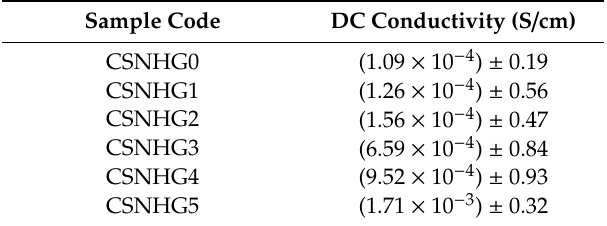
Table 2. Calculated DC conductivity for CS:NH 4 F:Gly electrolyte films at room temperature. Sample